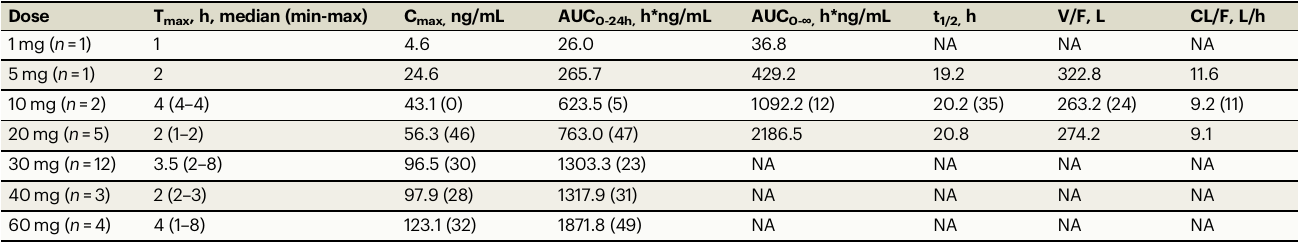
Dose T max , h, median (min-max) C max,